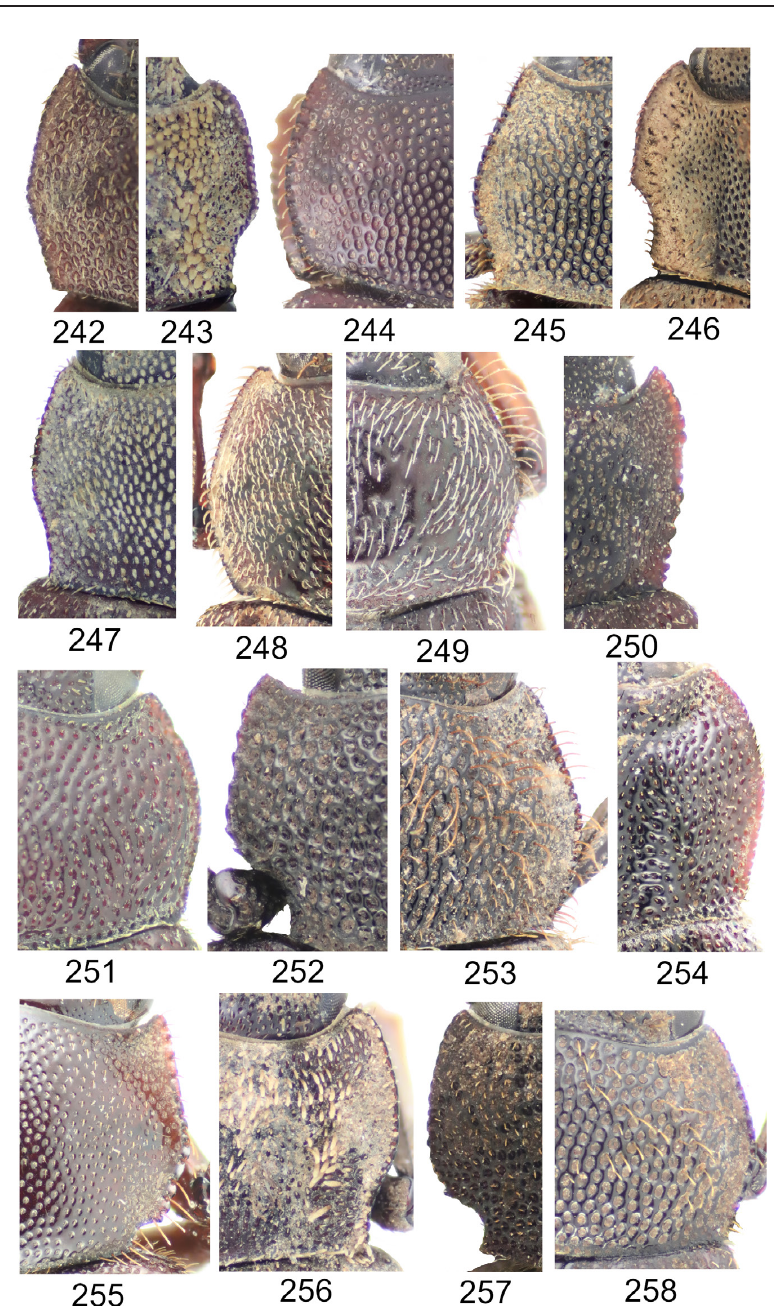
Figs 242–258. Papuan and Wallacean Maechidius Macleay, 1819, pronotum, dorsal view. 242 . M. paupianus Heller, 1910, lectotype, ♀ (SNSD). 243 . M. pauxillus Heller, 1910 comb. rest., lectotype, ♂ (SNSD). 244 . M. pedarioides Arrow, 1941, syntype, ♂ (BMNH). 245 . M. peregrinus Lansberge, 1886, ♂ (DTC). 246 . M. perlatus (Frey, 1969) comb. nov., ♂ (SMNS). 247 . M. popei (Frey, 1969) comb. nov., holotype, ♀ (BMNH). 248 . M. riedeli sp. nov., holotype, ♂